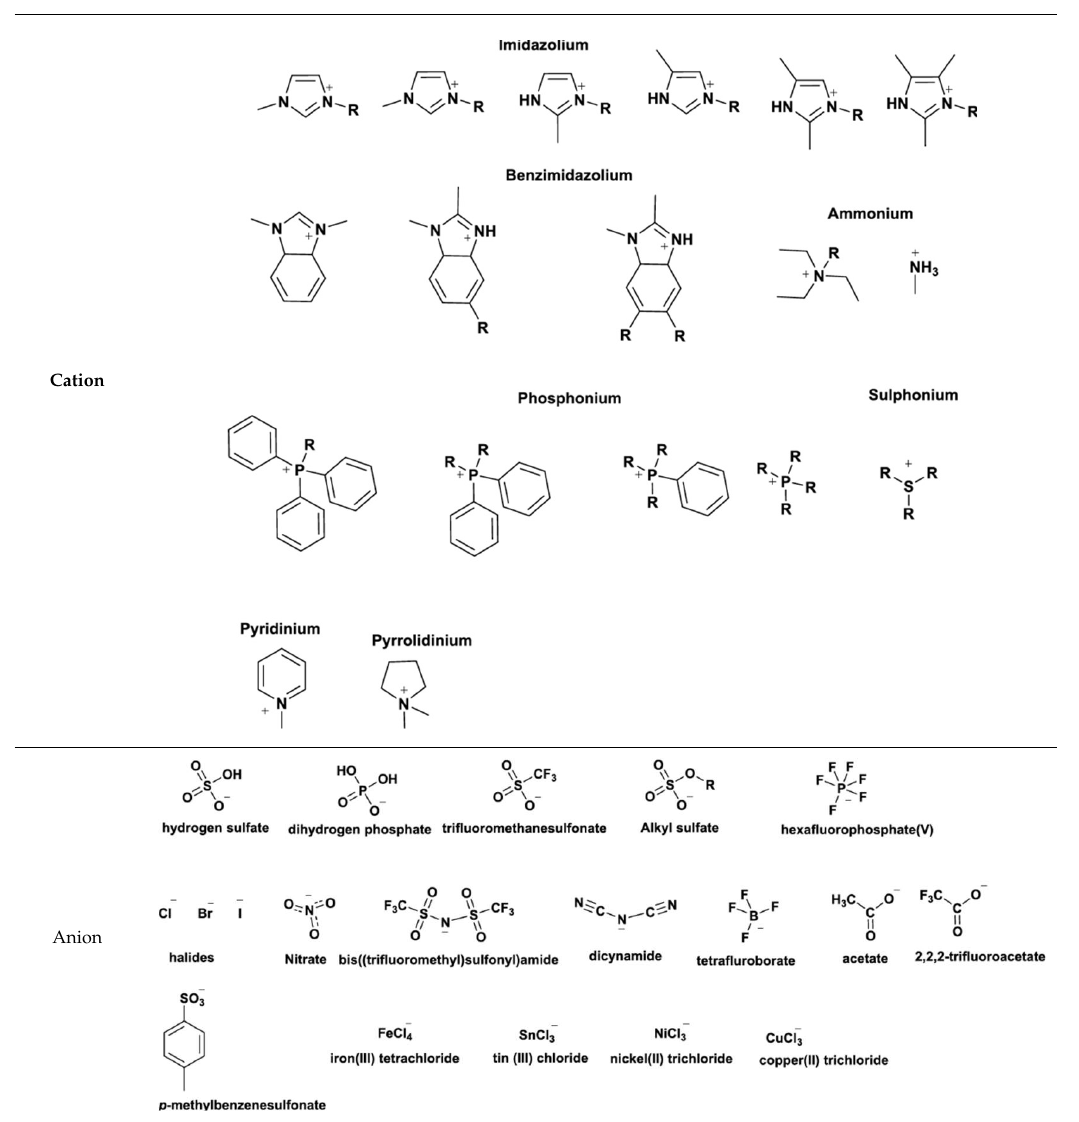
Table 2. Structures of most common ions used in designing ionic liquids. Adapted, with permission of ref. [5], copyright, 2020, Elsevier.